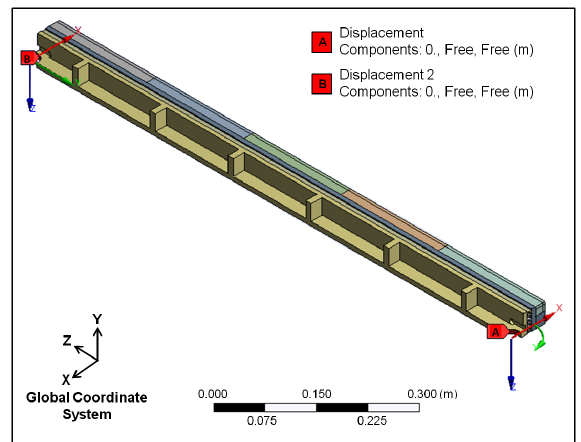
FIG. 13. Back view of the collimator jaw assembly simply supported at its extremities.